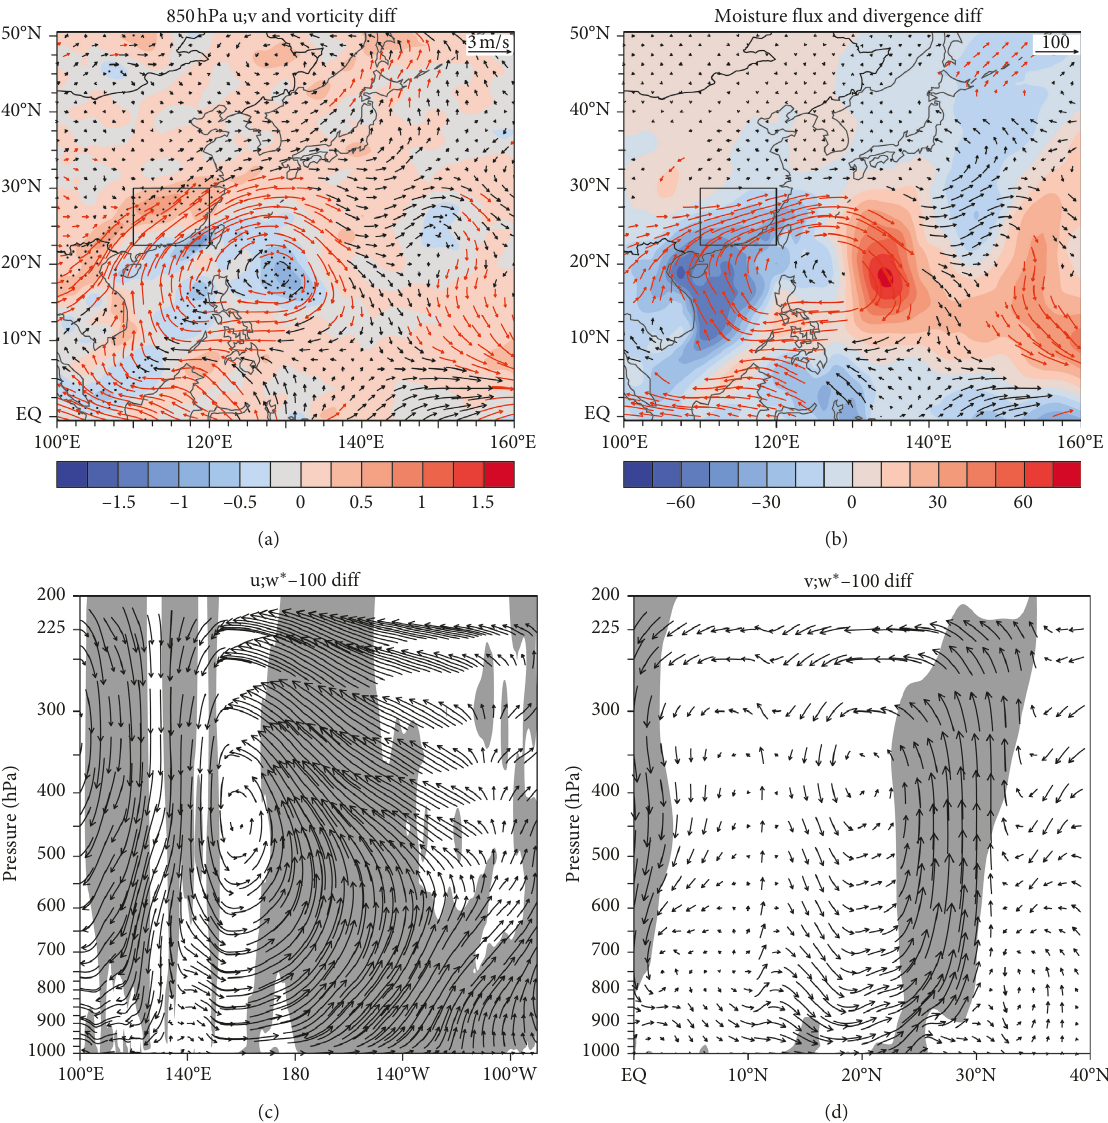
Figure 5: The difference between positive anomaly year and negative anomaly year: (a) 850 hPa horizontal wind (vector: m · s − 1 ; red vector: through the significance t -test at 90% confidence level) and vorticity (shadow: 10 − 5 s − 1 ; dotted part: exceeding the